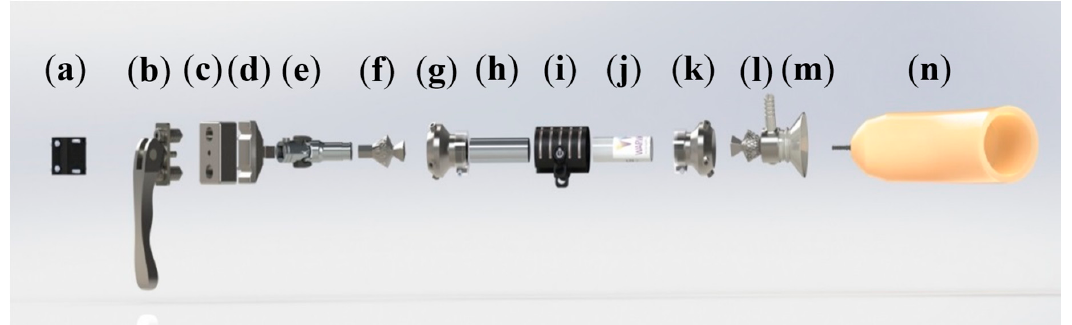
Figure 7. Final prosthetic design (exploded view): ( a ) Handlebar Connection; ( b ) Spring plunger release system; ( c ) Middle-block; ( d ) Slider; ( e ) Universal joint (with custom restrictor); ( f ) Male tube clamp adapter; ( g ) Female tube clamp adapter joint; ( h ) Lower-middle pylon; ( i ) Clamp release; ( j ) Upper-middle pylon; ( k ) Female tube clamp adapter joint; ( l ) Male tube clamp adapter; ( m ) Plastic cast; ( n ) Iceross Sport Liner.